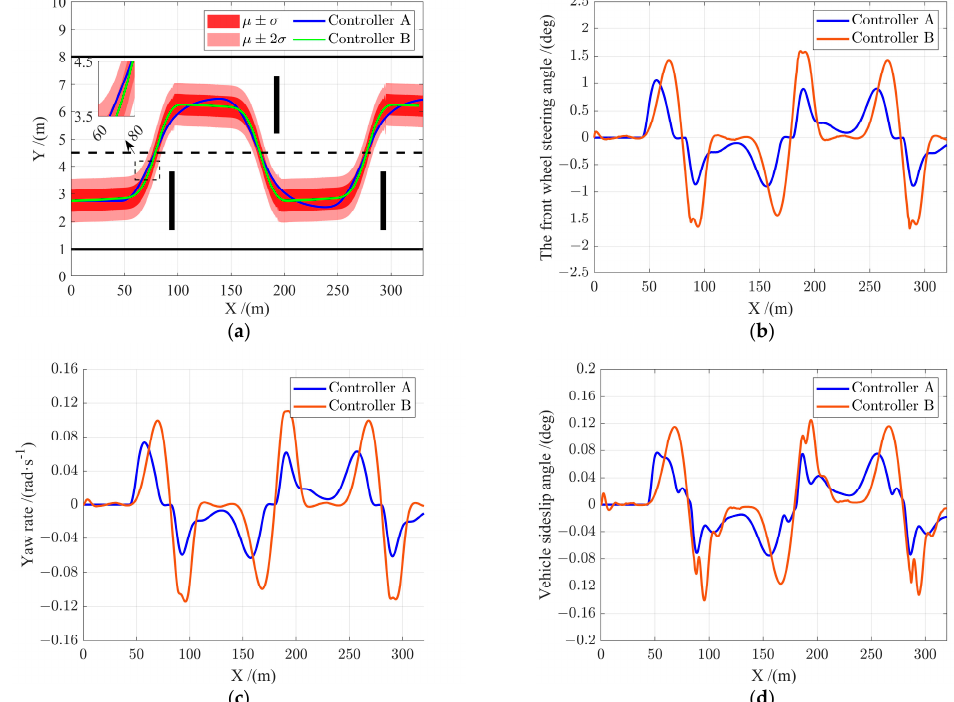
Figure 7. Experimental results of obstacle avoidance with ground adhesion coefficient 0.85. ( a ) GPR − based obstacle avoidance envelope and the obstacle avoidance trajectories. ( b ) The front wheel steering angle. ( c ) Yaw rate ( d ) Vehicle sideslip angle.